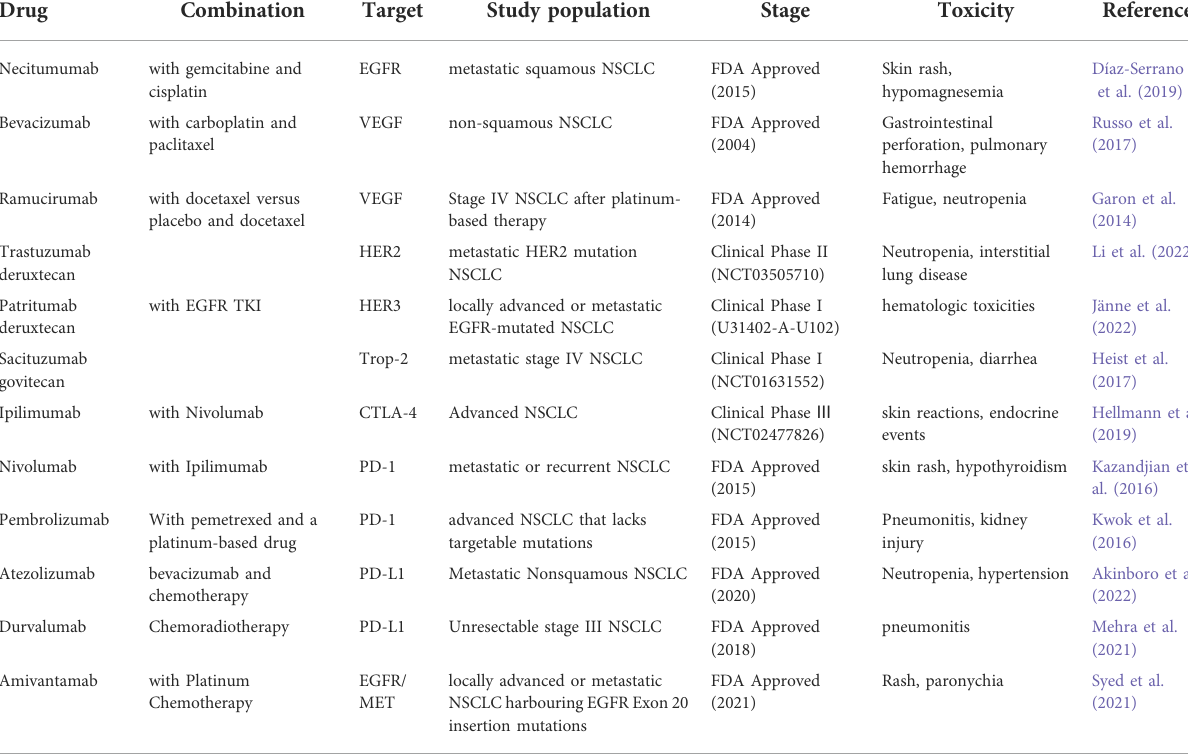
TABLE 1 Antibodies currently approved or in development for